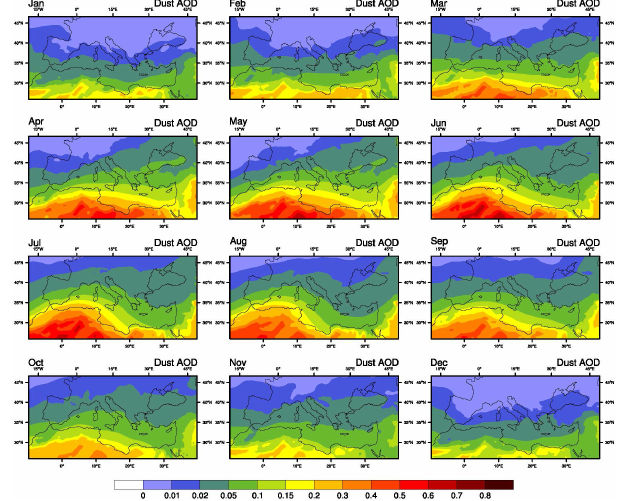
Figure 2. Monthly-averaged dust optical depth at 550nm (1979– 2013 period) over the Mediterranean region from the CNRM– RCSM5 regional coupled climate system model (after Nabat et al., 2015).